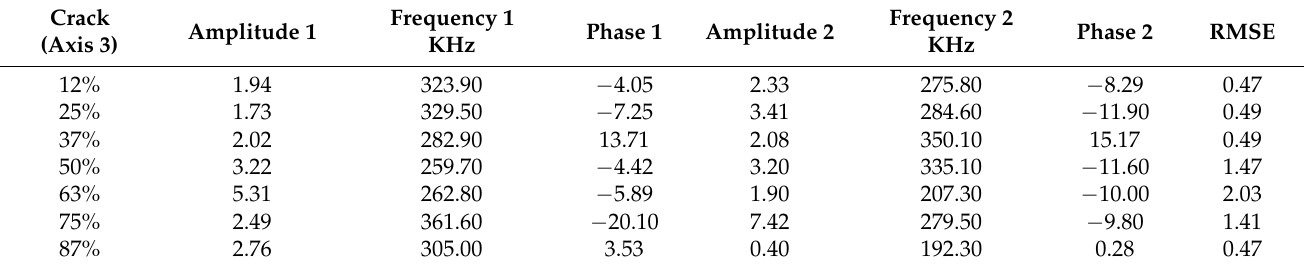
Figure 10. Comparison of the actual response and optimized mathematical model for the pipe with damage in axis 2. Table 5. Optimized parameters and error terms for the numerical model for the cracks along axis